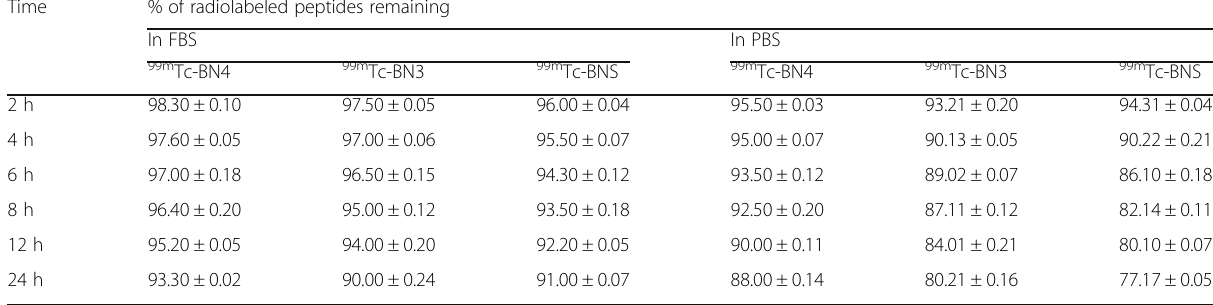
Table 1 In vitro stability of 99m Tc-BN3, 99m Tc-BN4, and 99m Tc-BNS in PBS and FBS after incubation for 2 to 24 h at 37 °C. Data were expressed as the mean ± SD